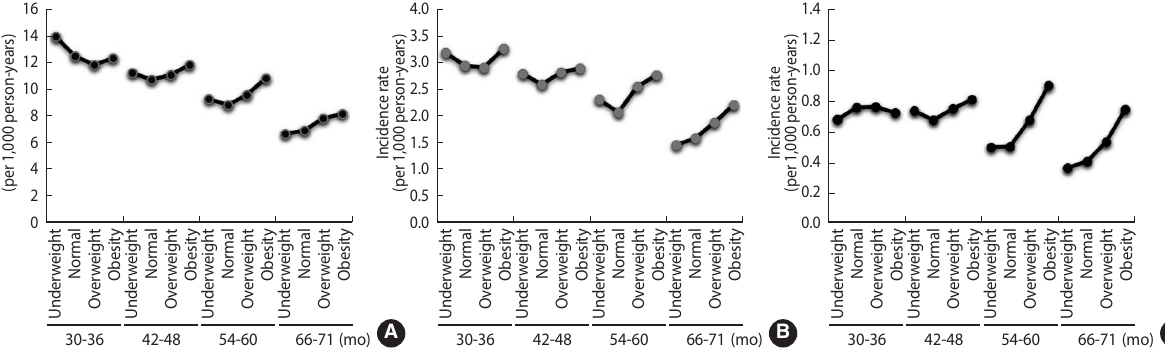
Figure 2. Incidence rates of (A) urinary tract infection (UTIs), (B) cystitis, and (C) acute pyelonephritis (APN), stratified by age groups and body mass index (BMI) categories. U-shaped associations between BMI categories and the incidence rates of UTIs, cystitis, and APN were found in children aged 42-48 Table 4. IRs of UTIs according to the examination periods of NHS for infants and children Variables